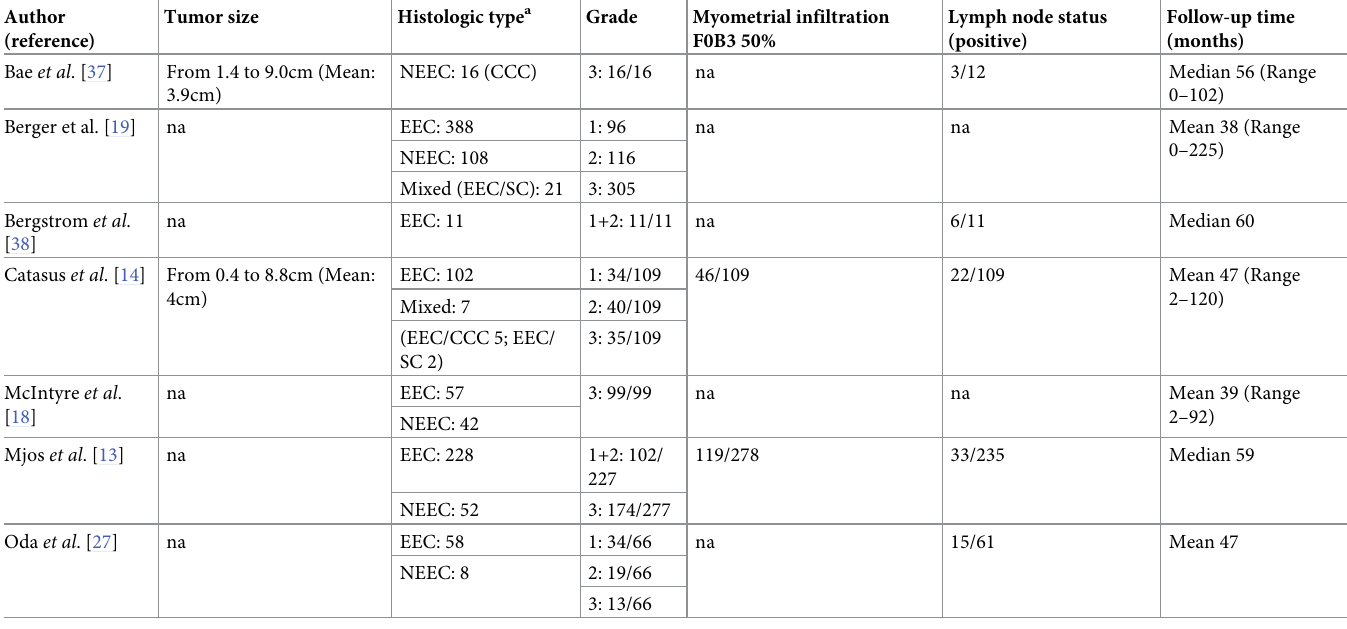
Table 2. Characteristics of patients enrolled in included